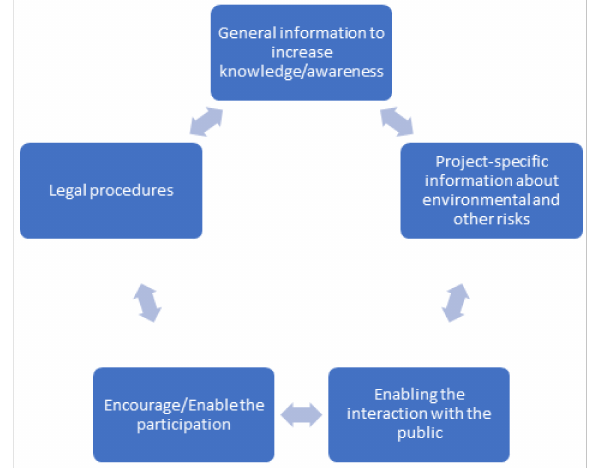
Figure 2. Social engagement strategy